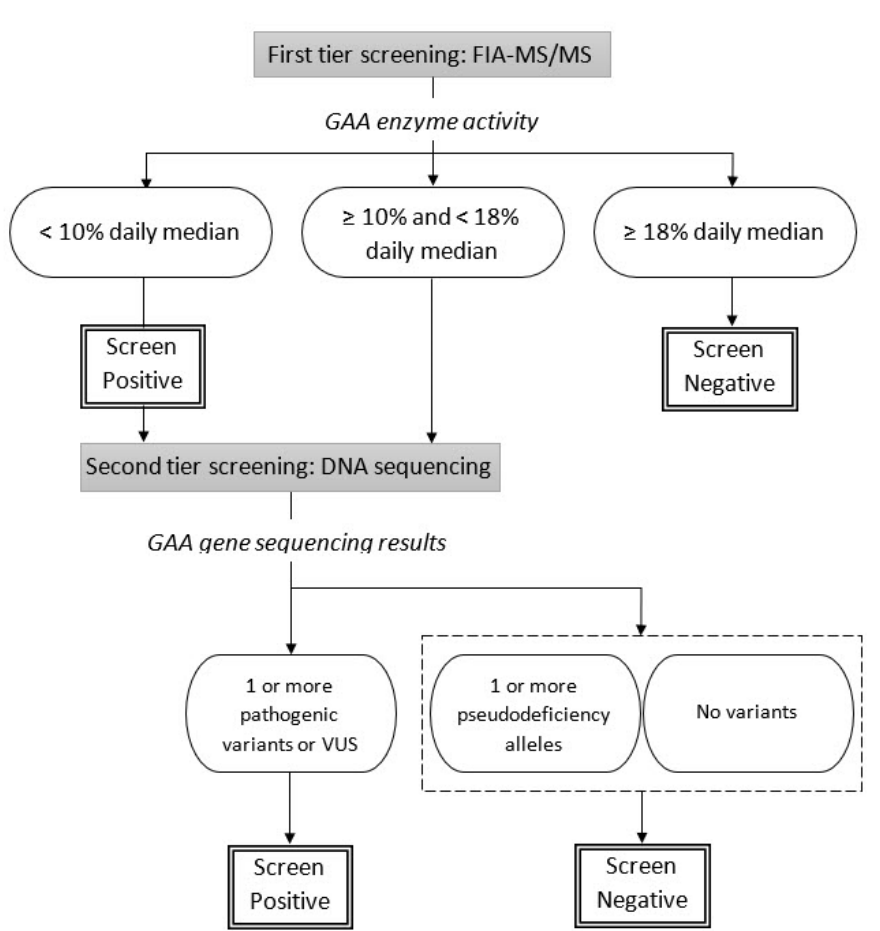
Figure 1. California Pompe disease newborn screening algorithm.